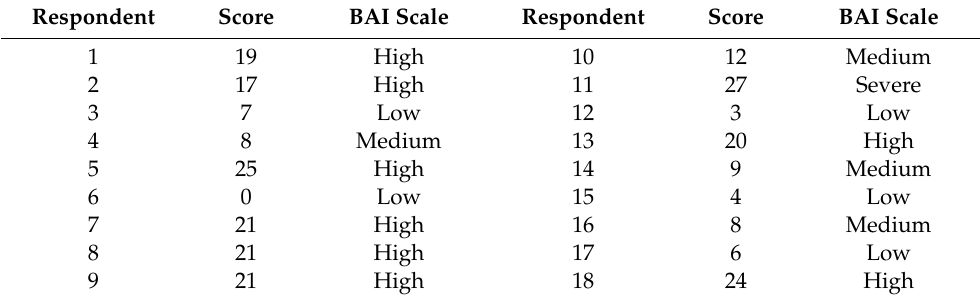
Table 9. User anxiety measurements